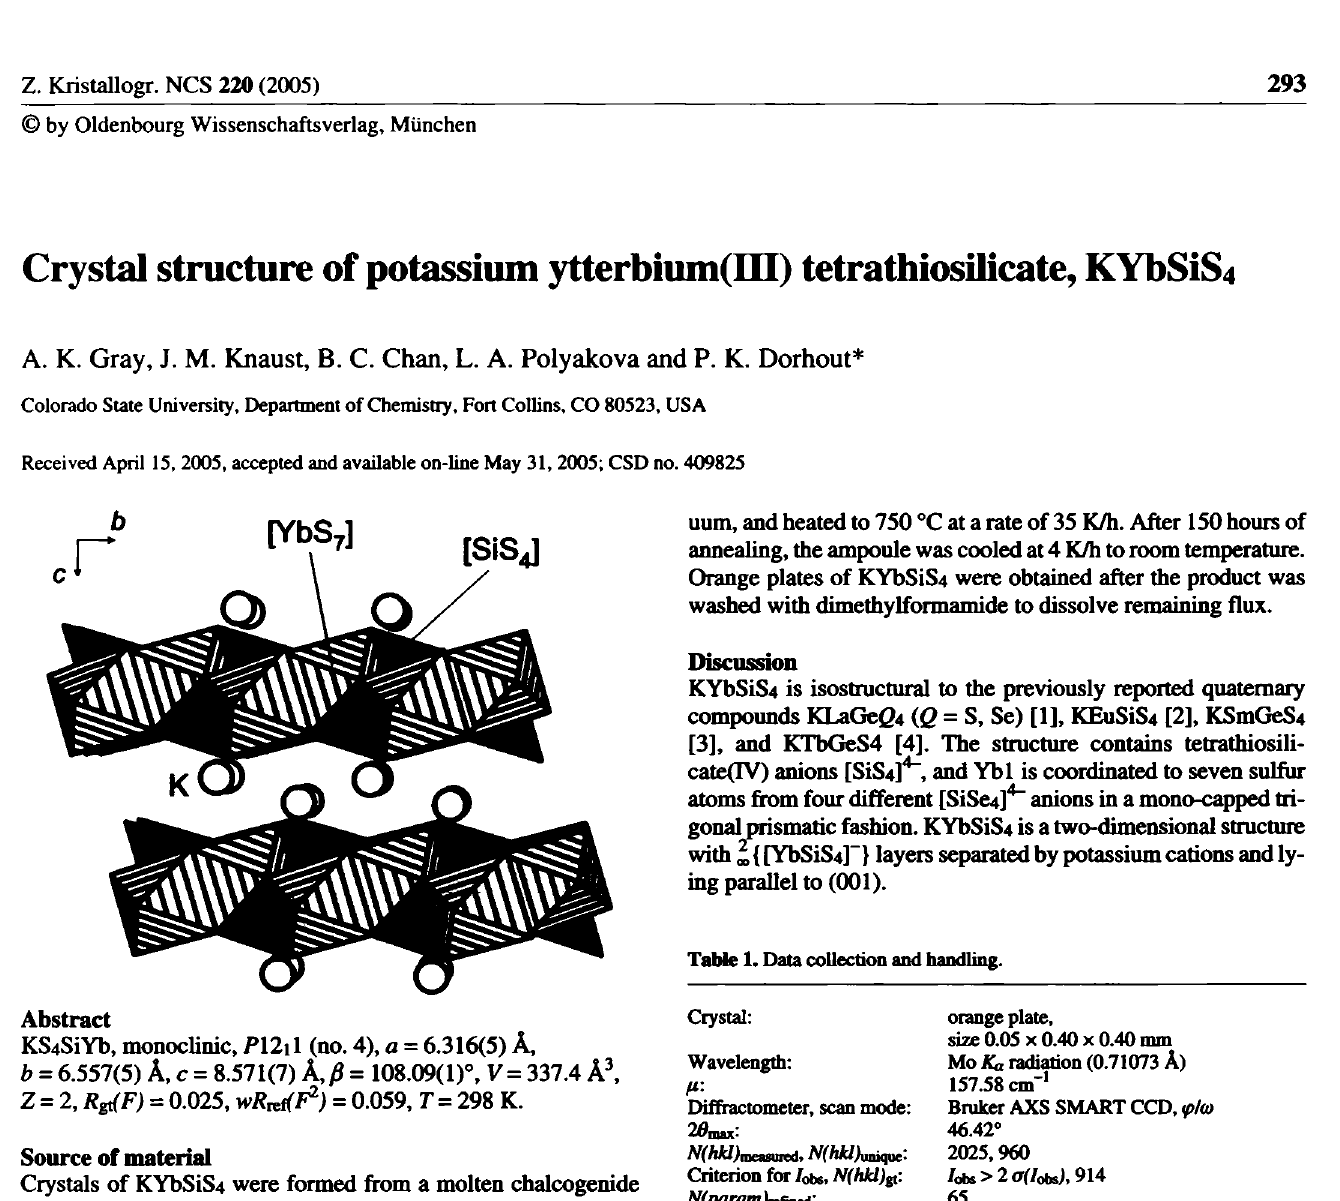
Table 2. Atomic coordinates and displacement parameters (in A 2